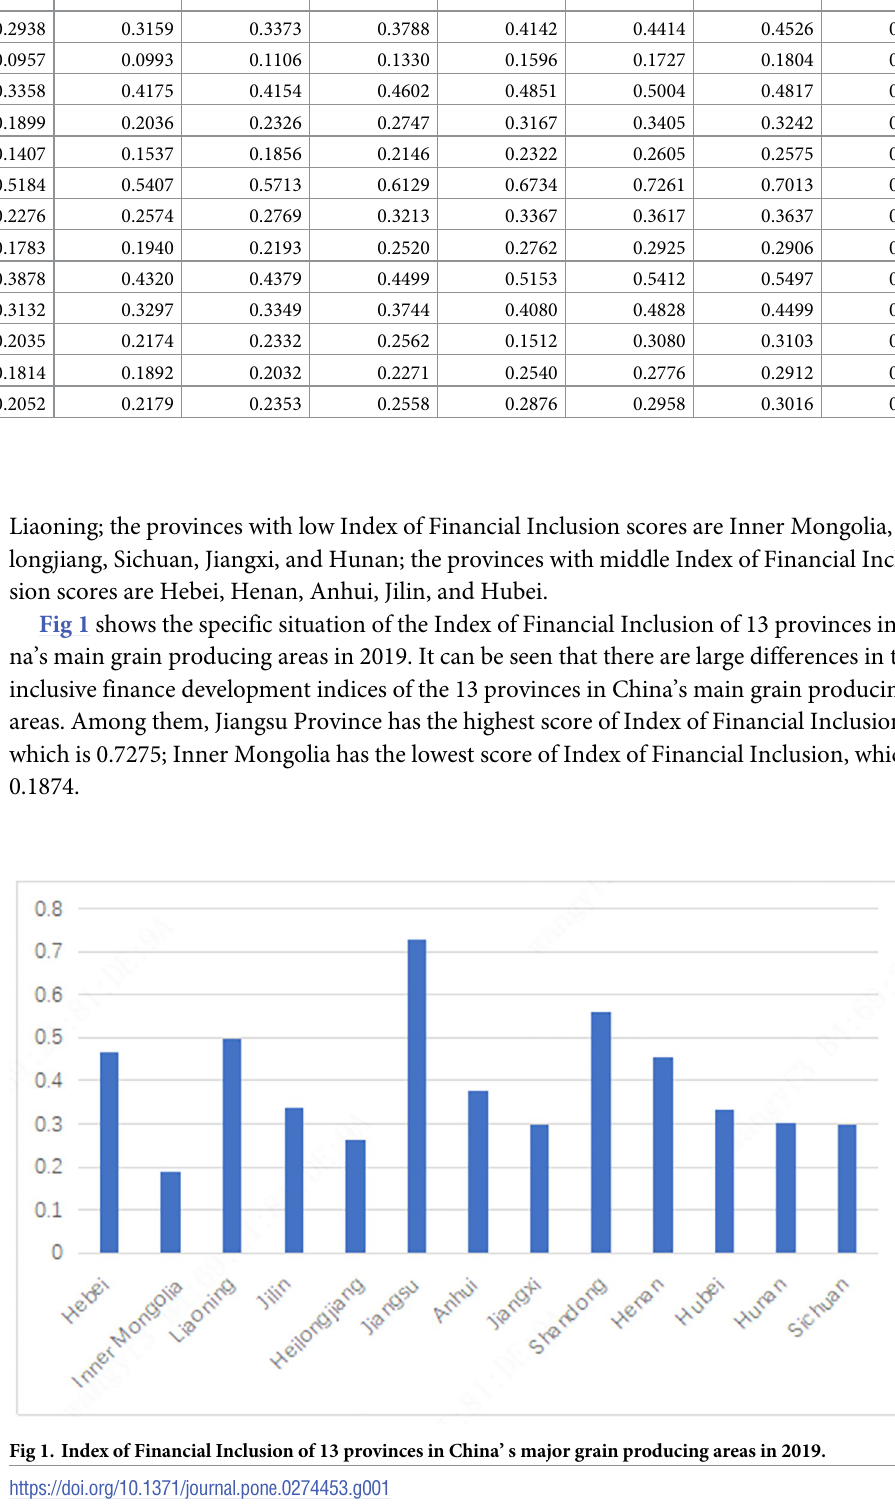
Fig 1. Index of Financial Inclusion of 13 provinces in China’ s major grain producing areas in 2019.